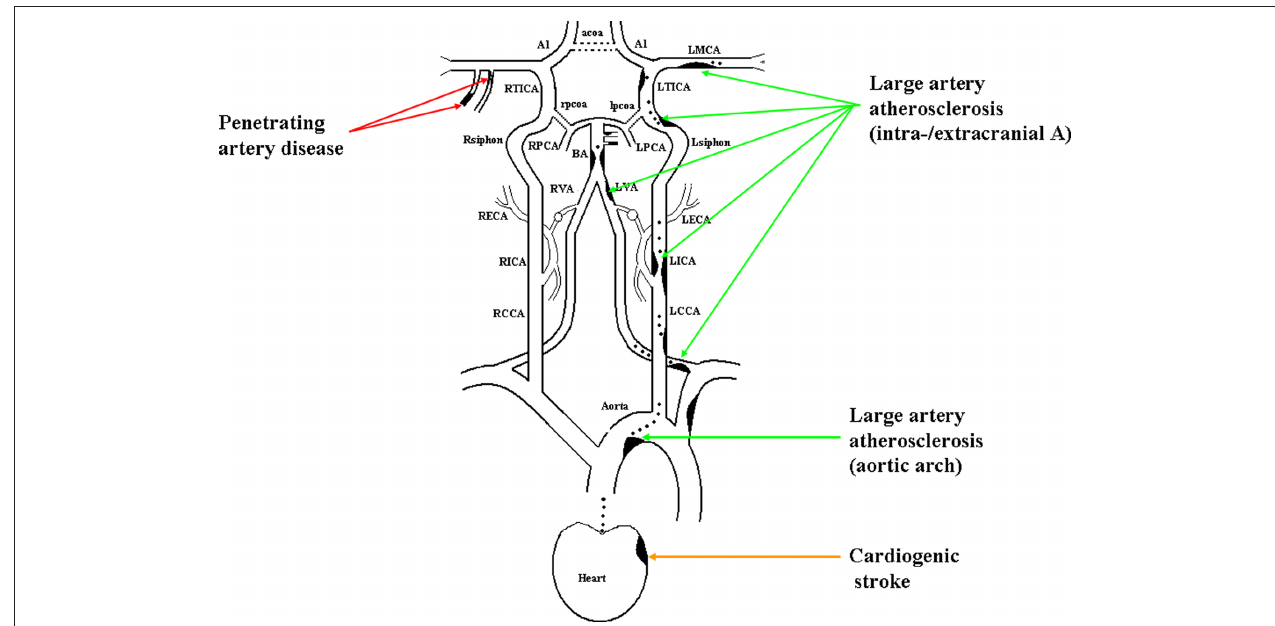
Figure 1 | illustration of large artery atherosclerosis, cardiogenic stroke, and penetrating artery disease.